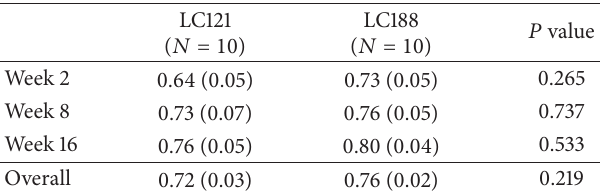
Table 5: T-maze testing and proportion of correct arm entries (baseline adjusted mean (SE)) of cats fed LC121 or LC188